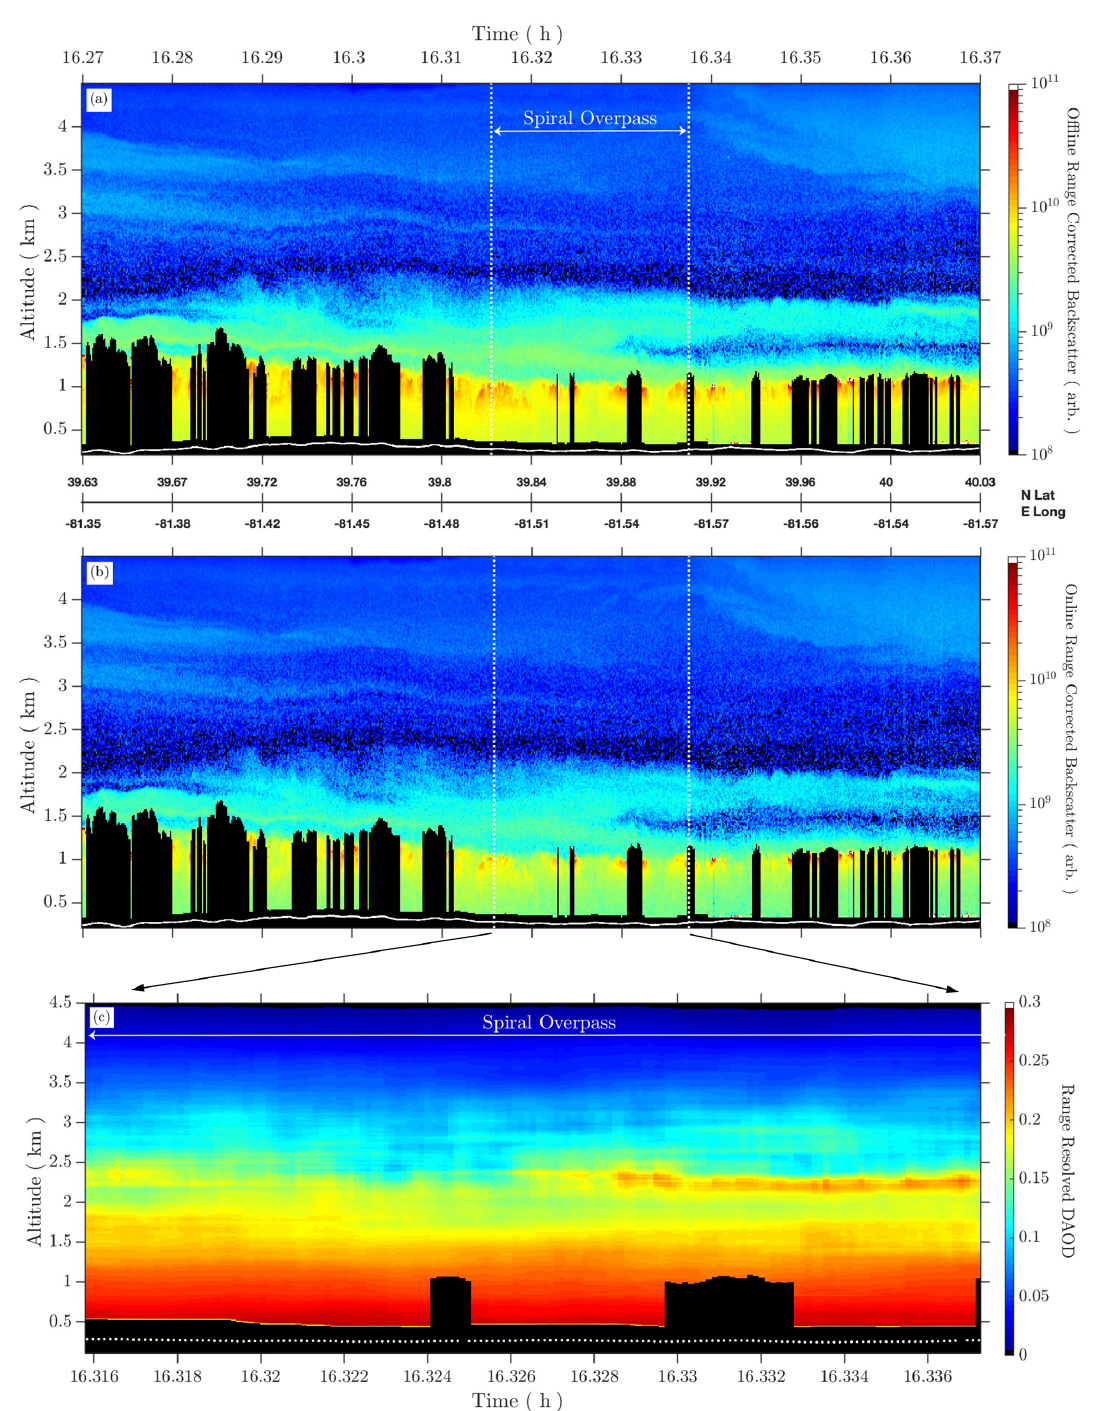
Figure 16. The 1645nm range-corrected backscatter (15m; 10s) from the 20 July in situ overpass subsection of Fig. 15. (a) Offline, 1645.3724nm. (b) Online, 1645.5518nm. The white bars in each panel indicate the overpass of the spiral location; see Fig. 10. Each curtain was cloud cleared and the DEM is overlaid. Panel (c) shows the calculated range-resolved DAOD at 350m vertical and 15s of along-track averaging within the overpass region defined in panels (a) and (b) . The lowest retrieval bin occurs one 350m range cell above the DEM due to the large vertical retrieval